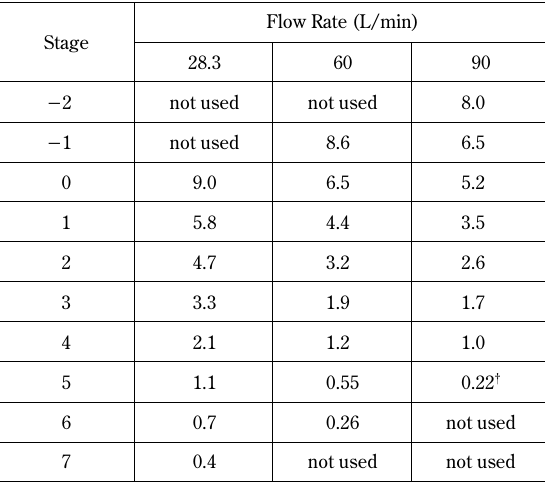
† Cut size reported by Thermo Andersen for this stage is 0.43 µ m Data at 28.3 L/min are nominal values supplied by the manufacturer, data at 60 and 90 L/min are from [67] and